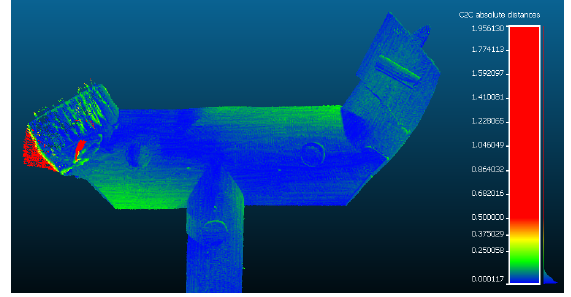
Figure 11. Error map backpack vs TLS survey. Figure was ob- tained by using CloudCompare. Red values corresponds to higher error values. Values are saturated at 50cm (red values start ap- proximately at 38cm, as shown in the color bar on the